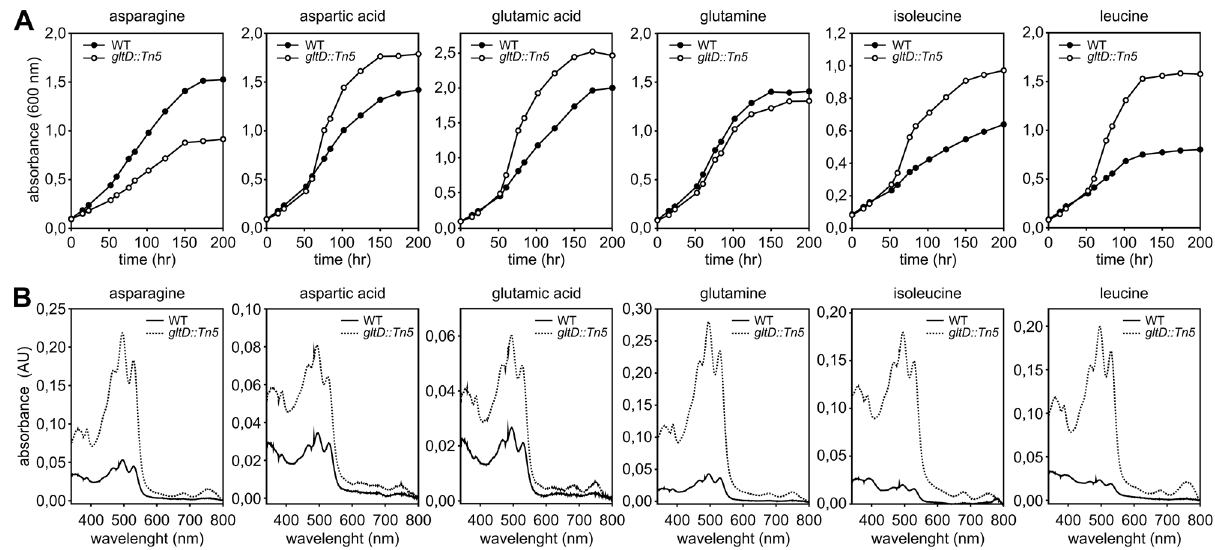
Figure 2. Growth and carotenoid production of the Bradyrhizobium ORS285 gltD::Tn5 strain using different amino acids as nitrogen source. ( A ) Representative growth curves of Bradyrhizobium ORS285 and Bradyrhizobium ORS285 gltD::Tn5 in minimal BNM-B medium containing different amino acids as nitrogen source. ( B ) Absorbance spectra of carotenoids extracted from 45 mg (wet weight) Bradyrhizobium ORS285 and Bradyrhizobium ORS285 gltD::Tn5 cells at the end of the growth experiment shown in ( A addition, analysing the carotenoid content of bacterial cells showed that the ORS285 gltD::Tn5 mutant strain on all tested amino acids, and in particular when using asparagine, glutamine, isoleucine and leucine as N-source, produced a drastically increased amount of spirilloxanthin as compared to the WT strain suggesting that the photosynthetic activity is boosted in the mutant. (Fig. 2B). These experiments show that besides the inability to use certain N-sources, the nitrogen and most probably carbon metabolism of the ORS285 gltD::Tn5 mutant strain is drastically different from the WT strain. In the experiments, also a remarkable observation was made with the mutant strain expressing E. coli GdhA. The presence of the E. coli gdhA gene enabled the gltD::Tn5 mutant strain to use almost the same N-sources as WT ORS285 (Table S1). The only exceptions were the growth on KNO 3 (Fig. 1C; Table S1) and reduction of atmospheric dinitrogen (N 2 ) as measured by the acetylene reduction assay (ARA) (Fig. 1D). This suggests that with these two N-sources, the concentration of intracellular NH 4 + (and/or 2-oxoglutarate) is not sufficient to form glutamate in the reaction catalysed by E. coli GdhA. Expression of gltB/D operon in the presence of different N‑sources and in symbiosis. To meas- ure gltB/D expression, we have constructed a reporter strain in which gusA gene was placed under the control of the promoter region of the gltB/D operon (Fig. 3A). This reporter strain (ORS285 P GOGAT - gusA ) was sub- sequently grown in the presence of different nitrogen salts (NH 4 + /NO 3 - ) or amino acids that allow growth of the ORS285 gltD::Tn5 mutant strain and the β-glucuronidase activity was measured after 48 h of incubation at 28 °C. Between the majority of analysed N-sources there is only a slight (but statistical relevant) difference in β-glucuronidase activity (Fig. 3B). An exception are cells grown in the presence of the amino acid leucine for which the measured β-glucuronidase activity was 2 to 3.5 -fold higher as compared to cells grown in the pres- ence of other N-sources (Fig. 3B). To investigate the expression of the gltB/D operon during symbiosis, the ORS285 P GOGAT - gusA strain was used to infect the NF-independent and NF-dependent Aeschynomene species A. evenia and A. afraspera , respectively. Fifteen days post infection, some nodules were sliced and nodule sections were incubated with the β-glucuronidase substrate 5-bromo-4-chloro-3-indolyl-beta-d-glucuronic acid (X-Gluc). Blue staining of the central nodule tissue showed that the gltB/D operon is expressed in mature nodules of both A. evenia and A. afraspera plants (Fig. 3C, D). Although X-gluc staining is a qualitative measurement of gene expression, it should be noted that no significant difference in the colour could be detected by eye between the two species. Glutamate synthase (GOGAT) activity is required for nodule organogenesis in NF‑independ‑ ent Aeschynomene evenia plants. Bradyrhizobium ORS285 has a relative broad host range and depend- ent on the plant species uses a NF-independent or NF-dependent mechanism to establish a symbiotic interaction with Aeschynomene legumes 3 . To investigate the effect of the GOGAT mutation in the symbiotic interaction with a NF-independent host plant, we infected our model species Aeschynomene evenia with the WT, and ORS285 gltD::Tn5 , ORS285 gltD::Tn5 + gltD and ORS285 gltD::Tn5 + gdhA mutants. As previously observed for a GOGAT mutant in ORS278 on A. indica , the ORS285 gltD::Tn5 mutant failed to induce nodules on A. evenia . The most unexpected observation is the fact that the complementation of this mutant with gltD or gdhA resulted in two completely distinct phenotypes. Whereas introducing the gltD gene into the ORS285 gltD::Tn5 mutant